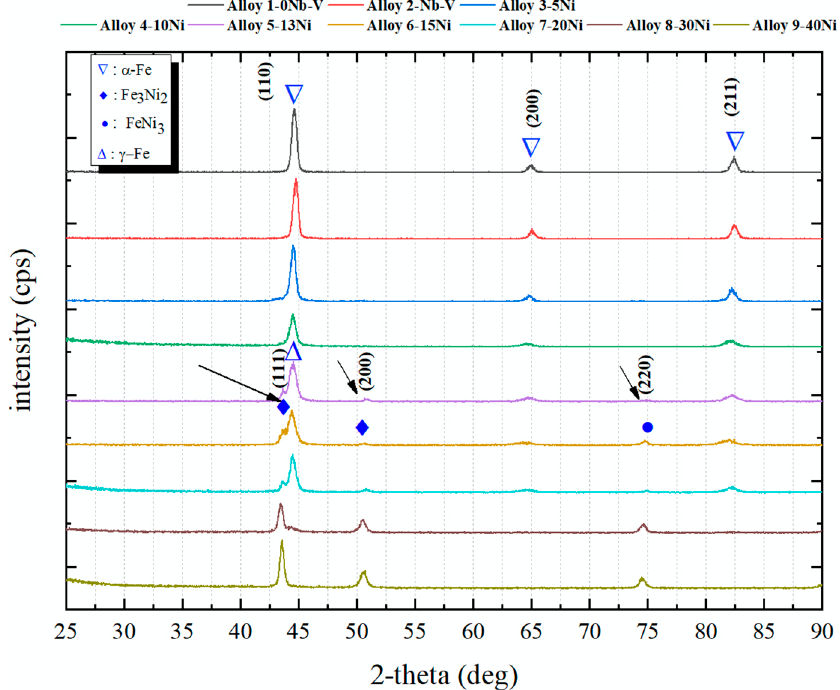
Figure 5. XRD patterns of the alloys.